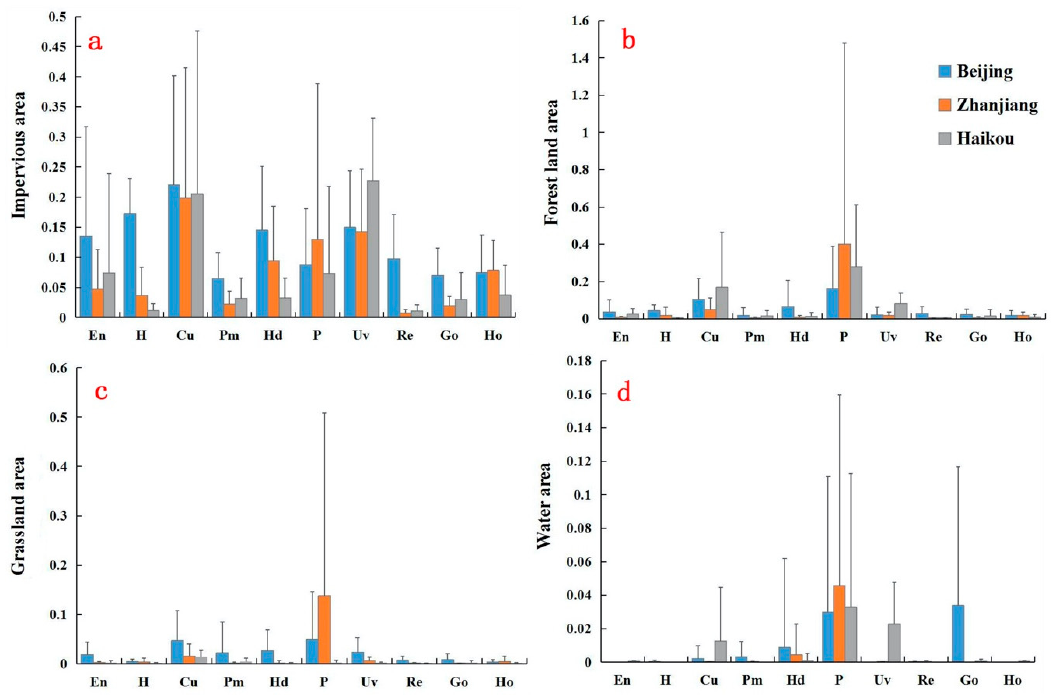
Figure 3. Areas of secondary urban functional units in Beijing, Zhanjiang, and Haikou for impervious area (km 2 ) ( a ), forest land area (km 2 ) ( b ), grassland area (km 2 ) ( c ), and water area (km 2 ) ( d